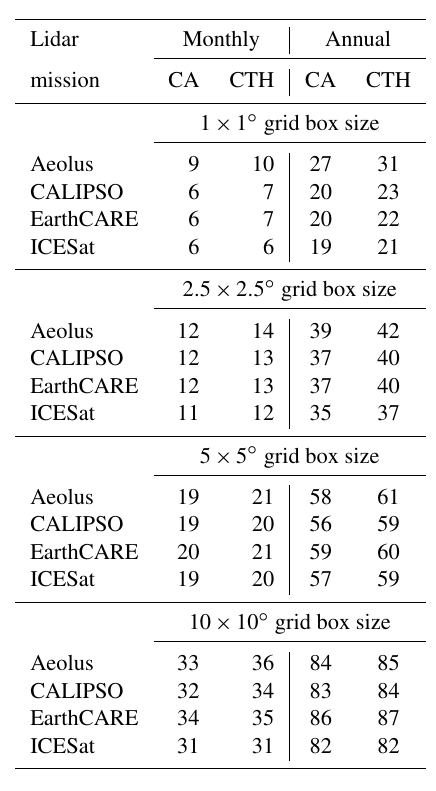
Table 4. The fraction (%) of locations (specifically, grid boxes within the Meteosat field of view) that met the accuracy criterion of 1% for cloud amount (CA), and 150m for cloud top height (CTH), at monthly and annual